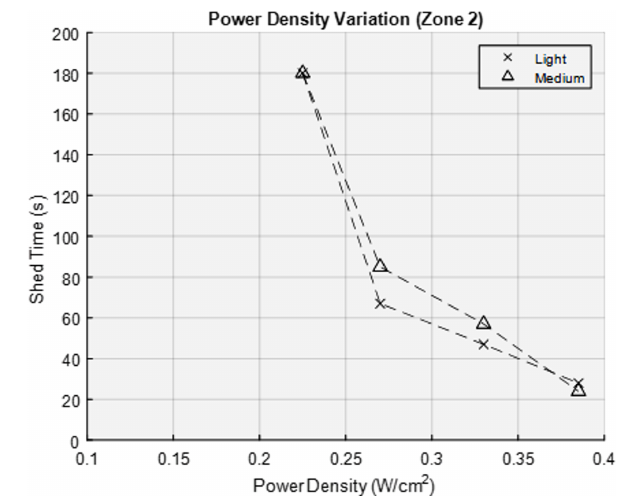
Figure 27. Repeatable time sequence for light icing conditions.